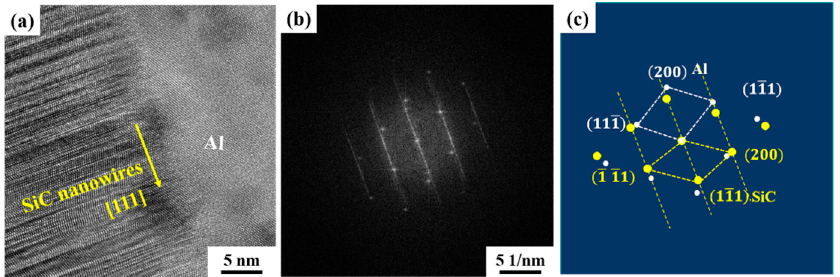
Figure 9. The HRTEM image of SiCnws/6061Al composite. ( a ) The interface between the SiCnws and Al matrix, ( b ) Corresponding SEAD patterns, ( c ) Calibration results of SEAD pattern in ( b ).